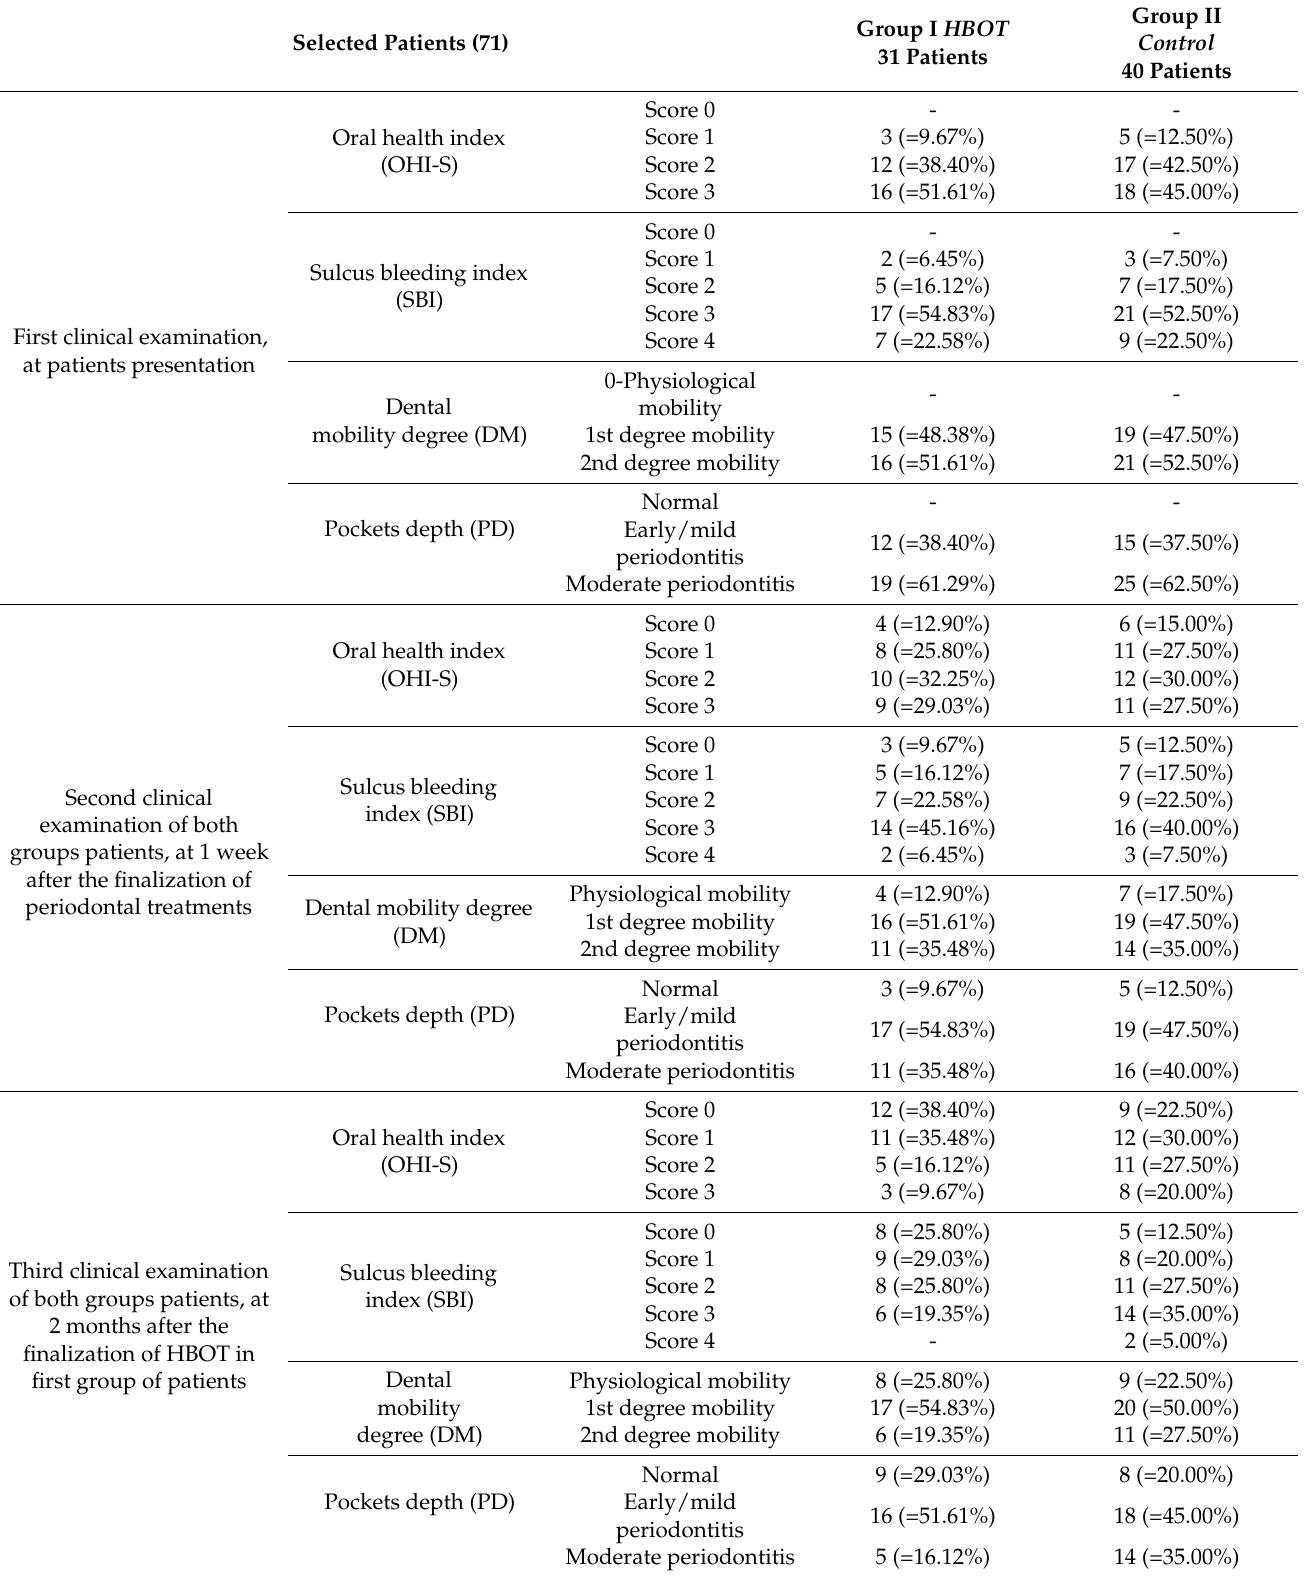
Table 4. Obtained results in the studied groups, according to the three clinical